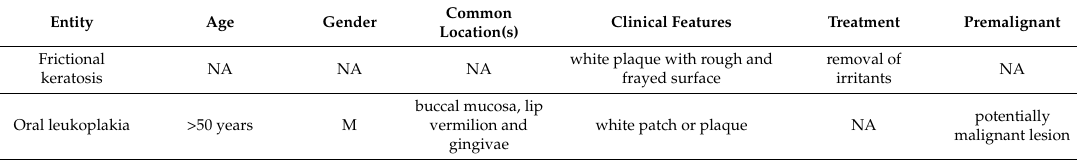
Table 4. Characteristics of acquired white lesions that cannot be scraped off, without specific